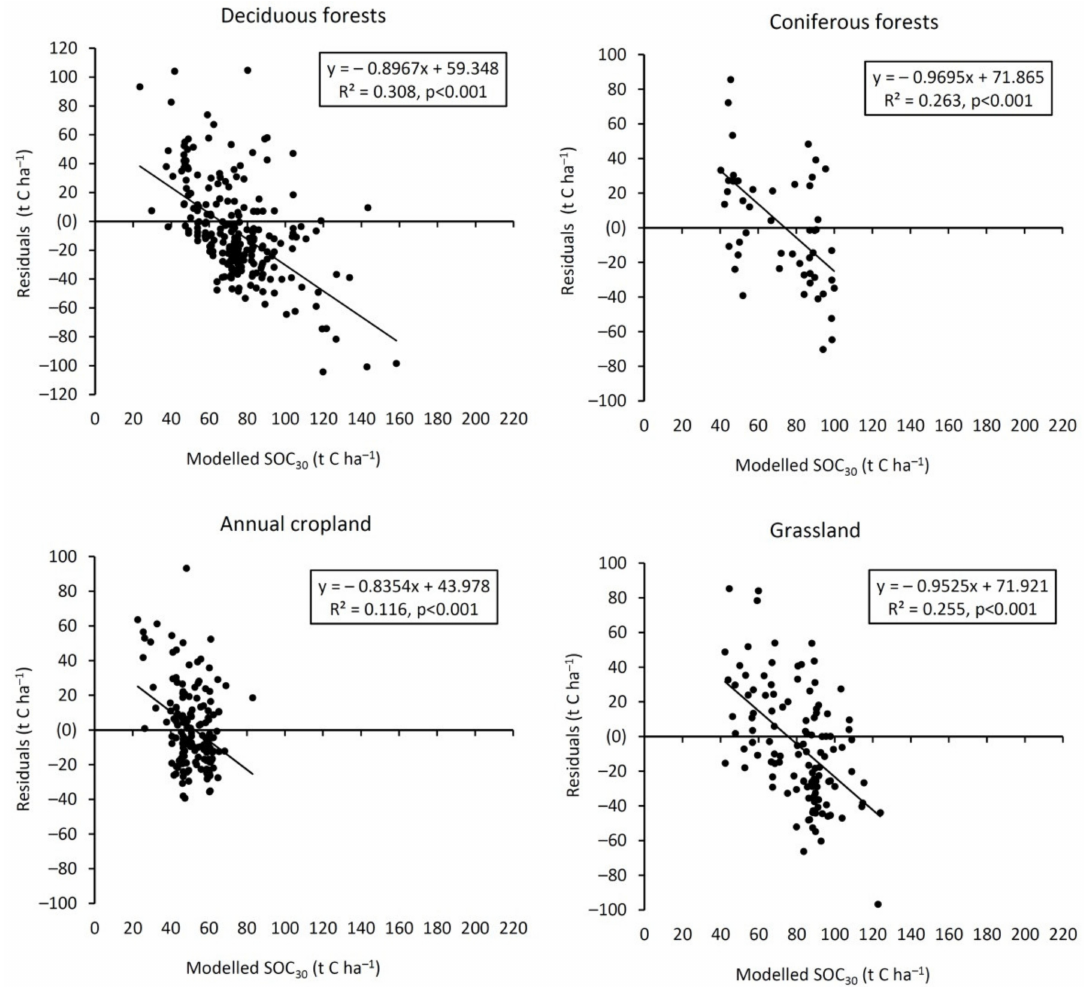
Figure A2. Residual analysis for different land-use